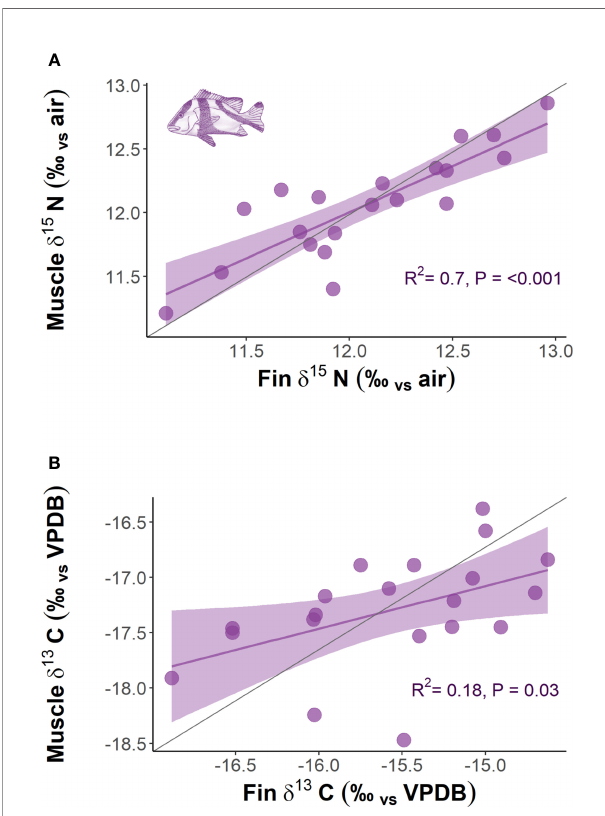
FIGURE 6 | The relationship between (A) d 15 N of dorsal muscle with fi n tissue and (B) d 13 C of dorsal muscle with fi n tissue for L. sebae . The grey line represents the 1:1